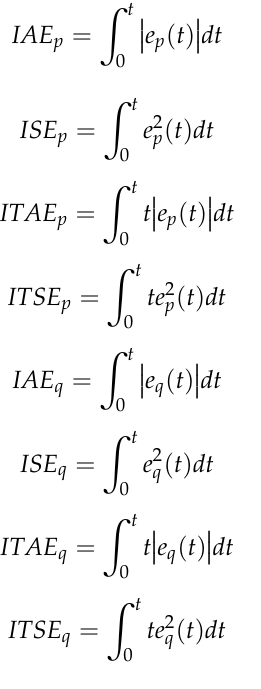
Figure 18. Dynamic performance comparison using active power: ( a ) integral absolute error (IAE), ( b ) integral time absolute error (ITAE), ( c ) integral square error (ISE), and ( d ) integral time square error (ITSE).